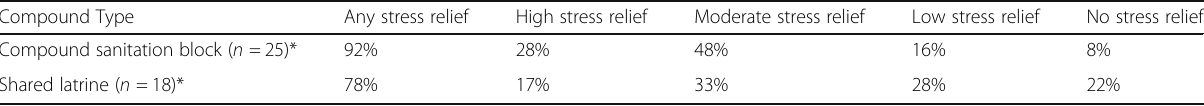
Table 2 Reported reduction in sanitation-related stress by intervention type among adult female in-depth interview participants Compound